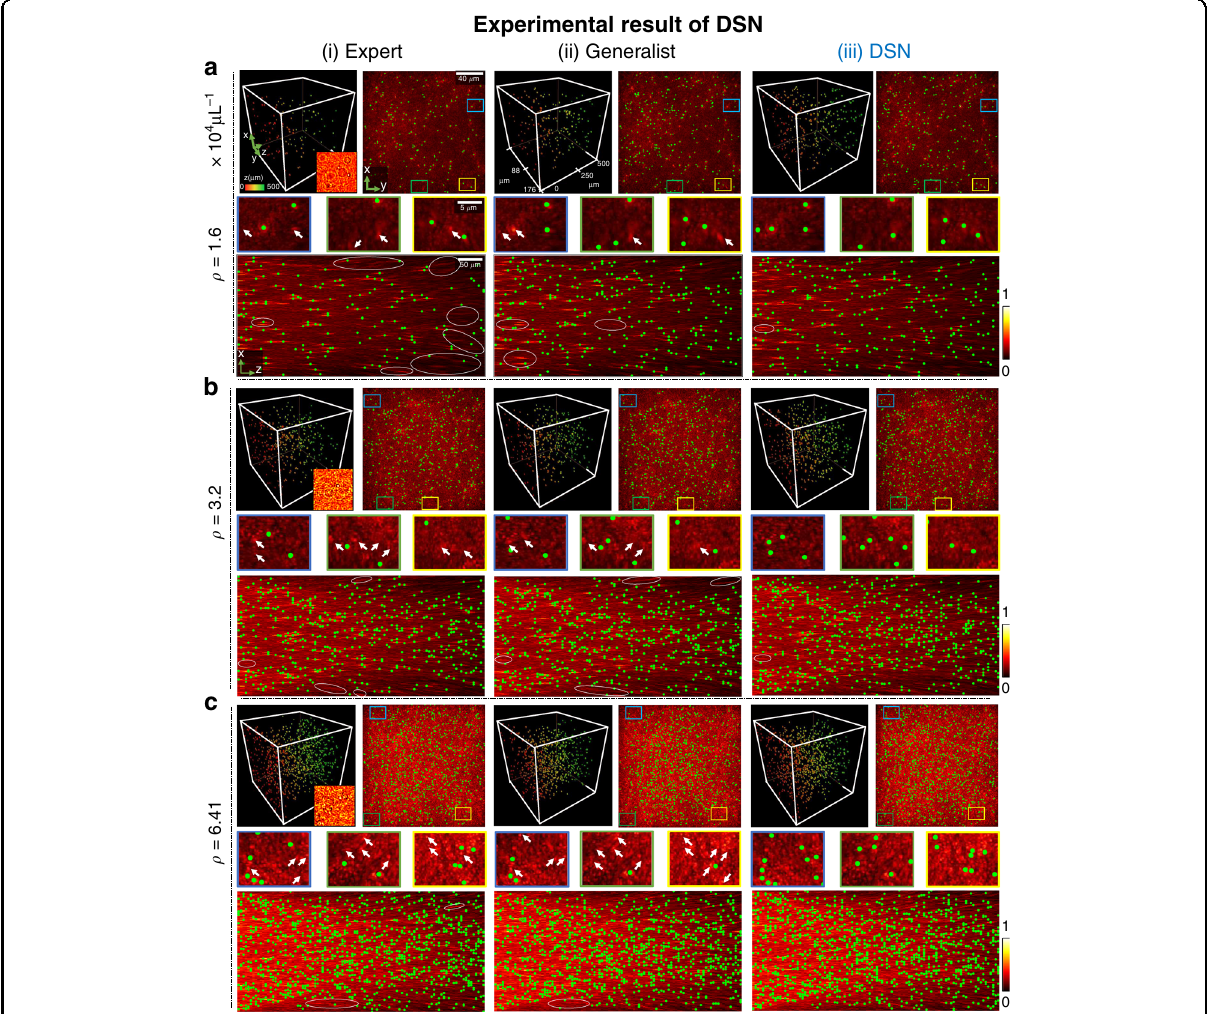
Fig. 8 Experimental results from simulator-trained DNNs. Particle 3D localization is shown for experimentally measured holograms using the simulator-trained (i) expert, (ii) generalist, and (iii) DSN networks at three-particle densities. Each panel shows (Top left) the 3D rendering of the localization result with depth color-coded particles, with an inset showing a zoom-in of the measured hologram, (Top right) the maximum intensity z -projection along with three zoom-in regions, and (Bottom) the y -projection of the DSN ’ s 3D localization result (in green), overlaid on the respective y - and z -projections of the corresponding holographic backpropagations. Visually identi fi ed mis-detection regions are marked by white ovals in the y - projections and white arrows in the z